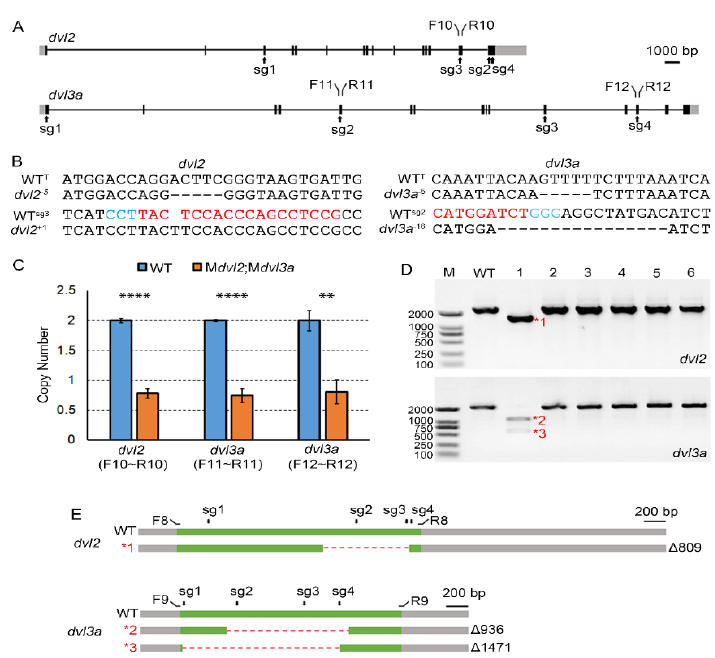
Figure 3. Genotyping double maternal mutants. ( A ) Gene structures of dvl2 and dvl3a , with primers and sgRNA targeting sites (sg1-4) as indicated. F10, R10, F11, R11, F12, and R12 are primers used in the qPCR analysis. Black boxes represent exons, and grey boxes indicate untranslated regions. ( B ) Indels identified from a 30 hpf MZ dvl2 ;MZ dvl3a embryo at dvl2 and dvl3a loci. WT T designates the wild-type sequence near the mutation decended from male dvl2 +/ − ; dvl3a +/ − mutant. ( C ) Ploidy determination of three genomic regions at dvl2 and dvl3a loci by qPCR. An amplicon from the dmd gene serves as a diploid reference (**** p < 0.0001; ** p < 0.01, Student’s t -test). ( D ) Representative gel analysis after amplifying the coding regions of dvl2 and dvl3a by RT-PCR. Two-cell stage embryos with GFP expression were individually lysed for extraction of total RNAs and RT-PCR analysis. Red asterisks and numbers designate truncated transcripts subjected to sequencing. ( E ) Mutant transcripts with large deletions observed in an M dvl2 ;M dvl3a mutant as shown in ( D ). Primers used to amplify the coding regions and dvl2 and dvl3a sgRNAs targeting regions are marked on the wild-type cDNA. Green bars indicate coding regions, whereas grey represents untranslated regions.